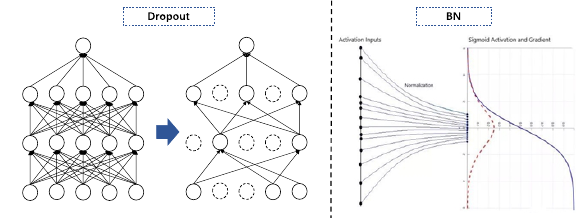
Figure 3. Dropout and BN schematics